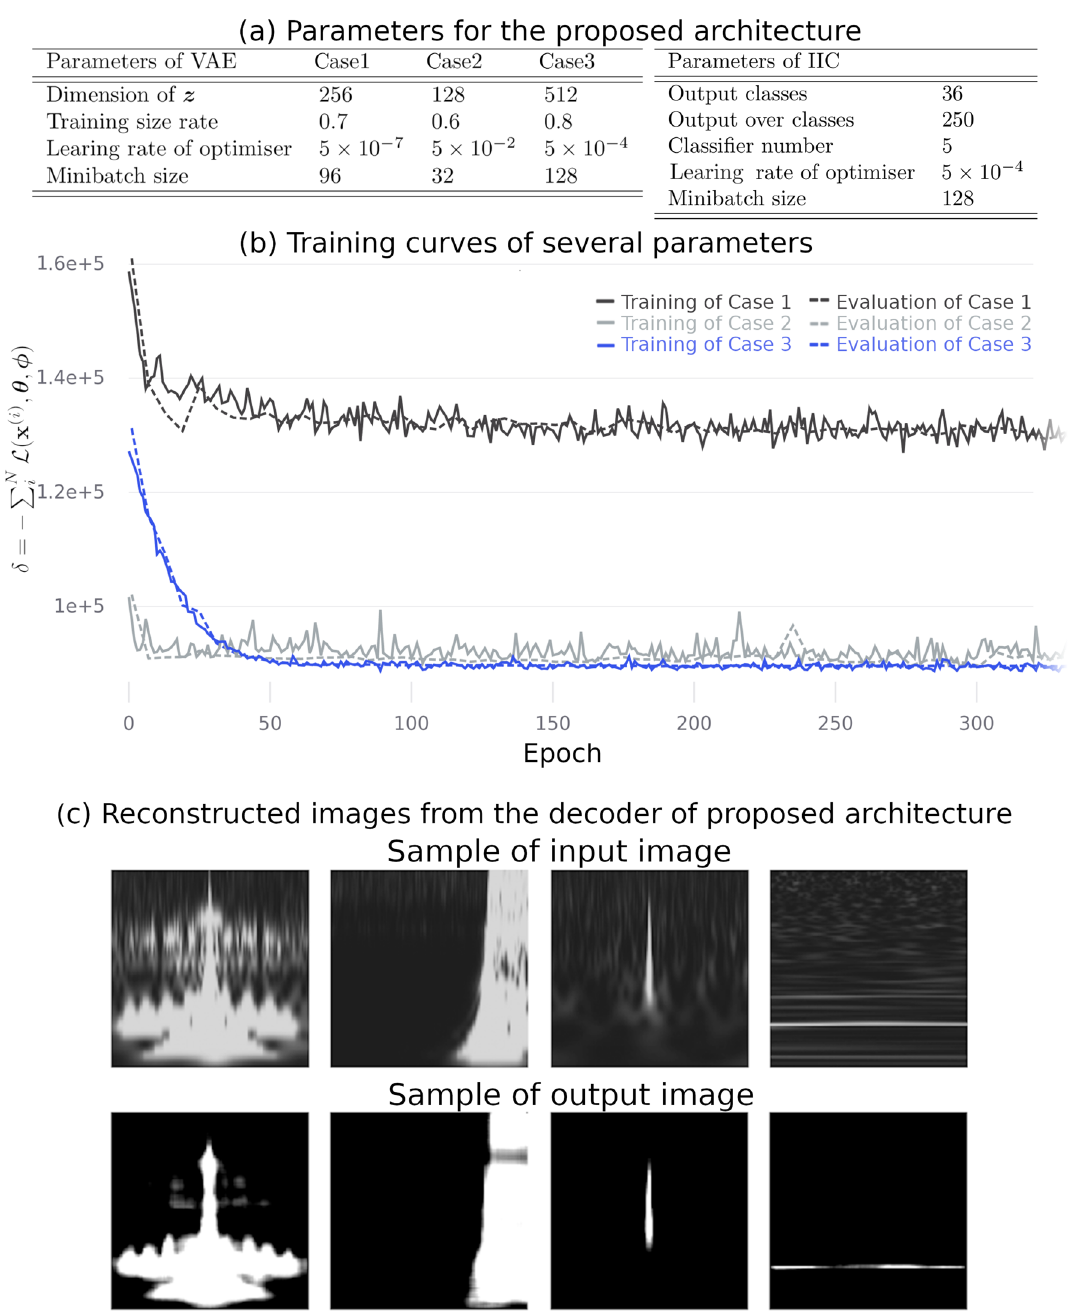
Figure 2. Left ( a ) Training parameters for the VAE of the proposed architecture. The dimension of z is the output number of the encoder. The training size rate is the ratio of the total number of data to the data size of the input at training. Regarding the architecture evaluation, the input size is set to ( 1 − Training size rate ) . The learning rate is the initial learning rate, and the optimiser used is Adam 31 . Right ( a ) Training parameters for the IIC of the proposed architecture. The number of output classes is set to the number of classes to be classified. The classifier number is for multiple classifiers that are used to improve the performance of the classifier using spectral clustering. ( b ) Training curve during the training and evaluation of the VAE. The solid and dashed N L ( x ( i ) , θ , φ ) at the time of training and evaluation, lines in the figure show the training objective δ ≡ − i respectively. ( c ) Reconstructed images generated by the decoder of the VAE at 100 epochs in Case (cid:31)